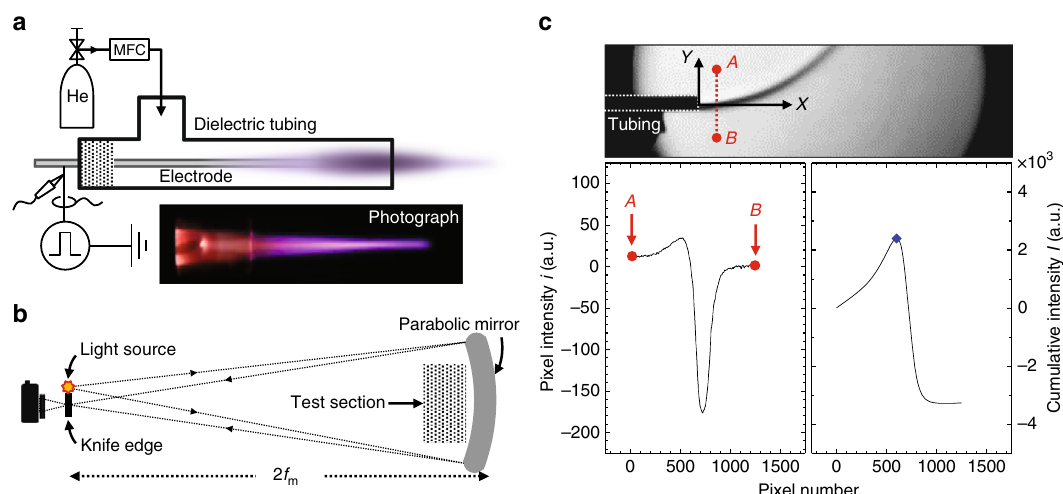
Fig. 5 Experimental apparatus for atmospheric-pressure plasma jet and Schlieren photography. a Schematic of a plasma jet actuator and relevant setup. The μ s-pulsed plasma jet was operated by applying a high-voltage pulse to the pin electrode in the presence of helium gas. A real image of a helium plasma jet is also shown in the inset of the fi gure. b Schematic of the custom-made Schlieren imaging system (single-mirror type) and c an example method for extracting the centerline of the helium fl ow from Schlieren images. The left and right graphs show the pixel intensity and cumulative intensity of a given Schlieren image,